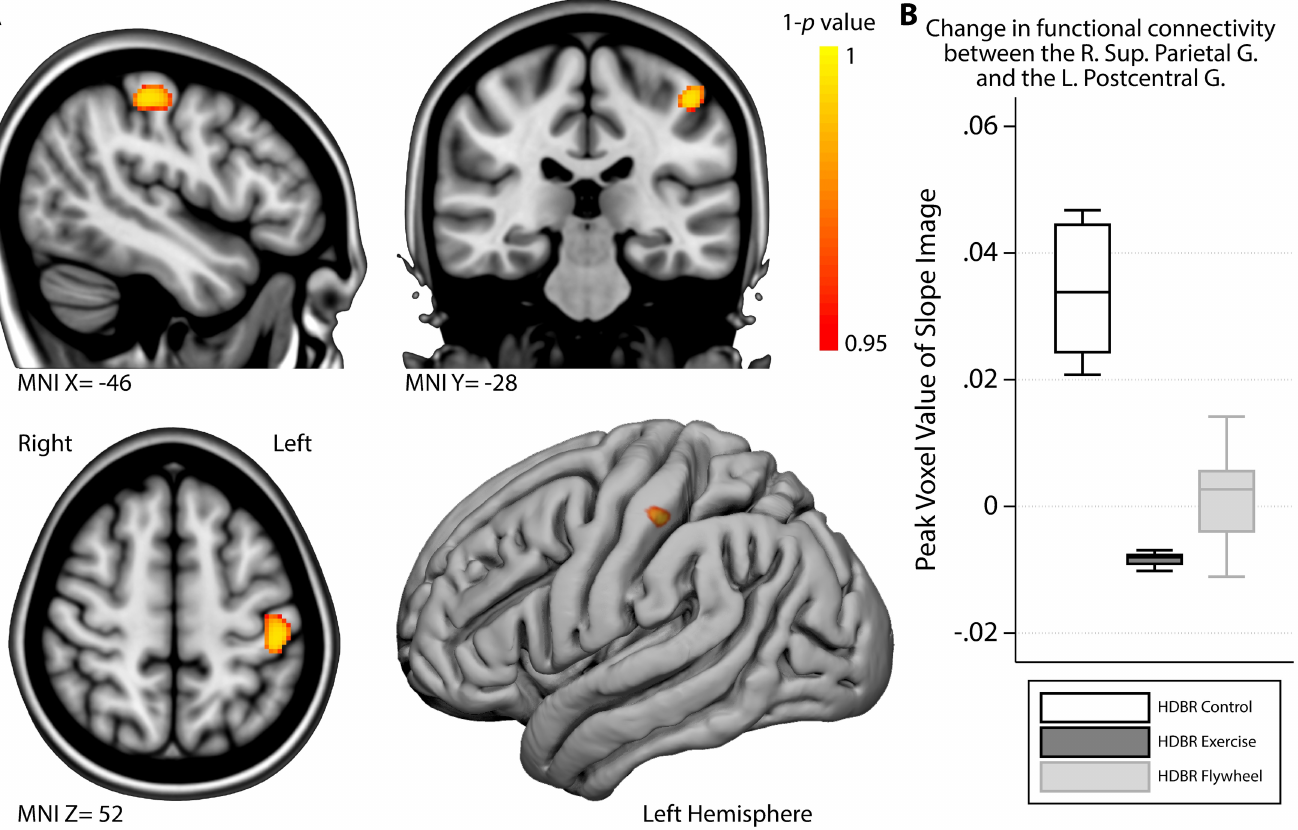
Fig 3. Exercise modulates functional connectivity strength between the right superior parietal gyrus and the left postcentral gyrus post-HDBR. A) Regions in which HDBR control subjects showed a significantly larger increase in functional connectivity between the Right Superior Parietal Gyrus and the Left Postcentral Gyrus than the HDBR exercise subjects during the post-HDBR phase. B) Boxplot of the functional connectivity strength measure (daily change in correlation) of the most significant ‘peak’ voxel in the area depicted in A, stratified by group. MNI = Montreal Neurological Institute coordinate; R. = Right; L. = Left; G. = Gyrus.